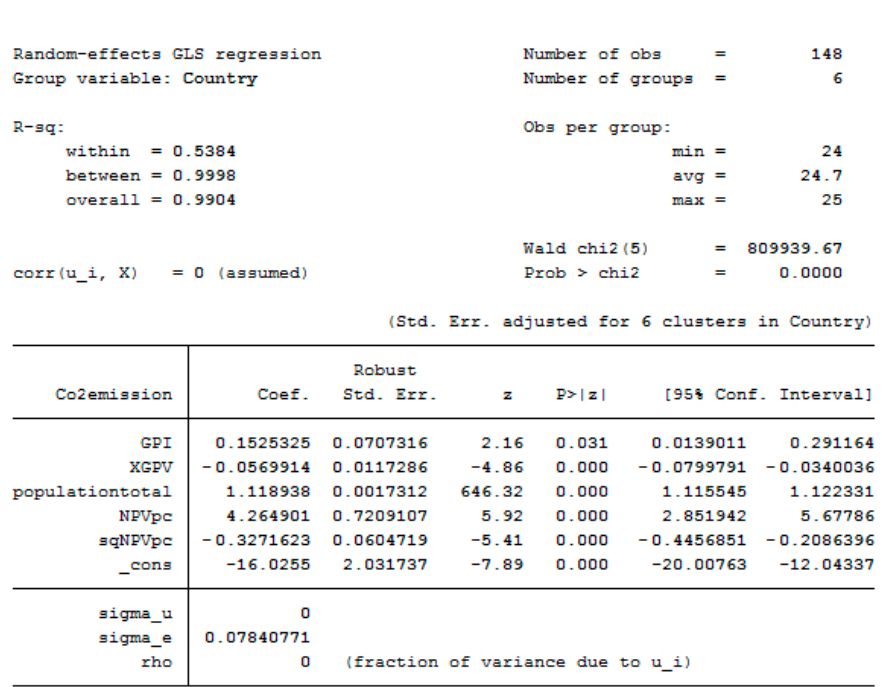
Figure 4. CO 2 model with random effects (RE). Source: Own calculations according to FAOstat data [27].